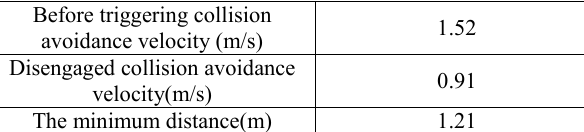
Figure 19 Pitch angle graph -